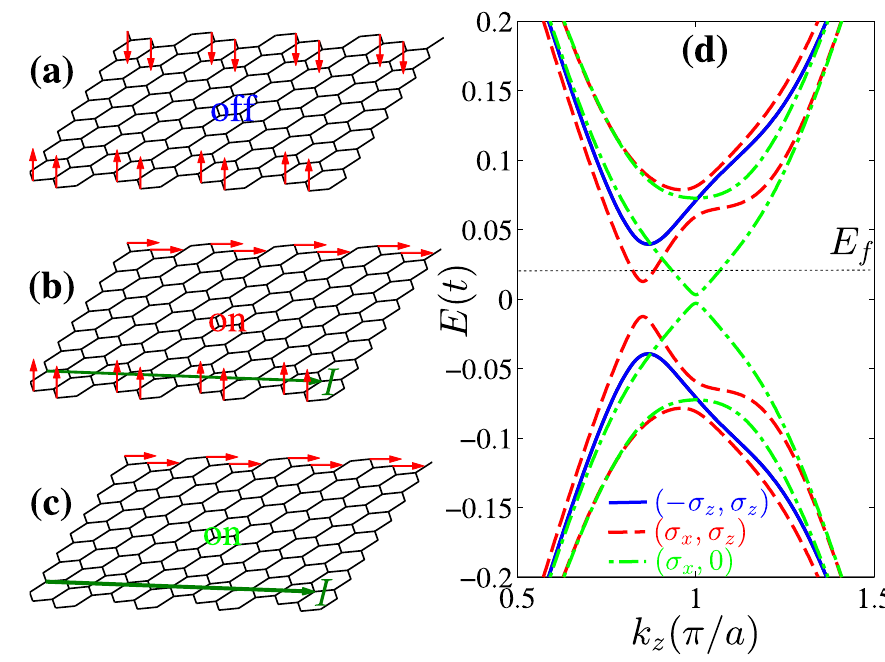
Figure 4. ( a – c ) Schematic diagrams of the nonlocal transistor manipulated by the magnetization orientation at the upper edge while the current flows at the lower edge. ( a ) Is for the off-state, ( b ) and ( c ) are for the two on- states. ( d ) Spectrum for the QSH edge channels for the nonlocal transistor based on a chiral ribbon (2,1) with width N = 8. The dotted line is the position of the Fermi energy. Three kinds of magnetization configurations shown in ( a – c ) are considered. Other parameters are λ = h = 0.1 t